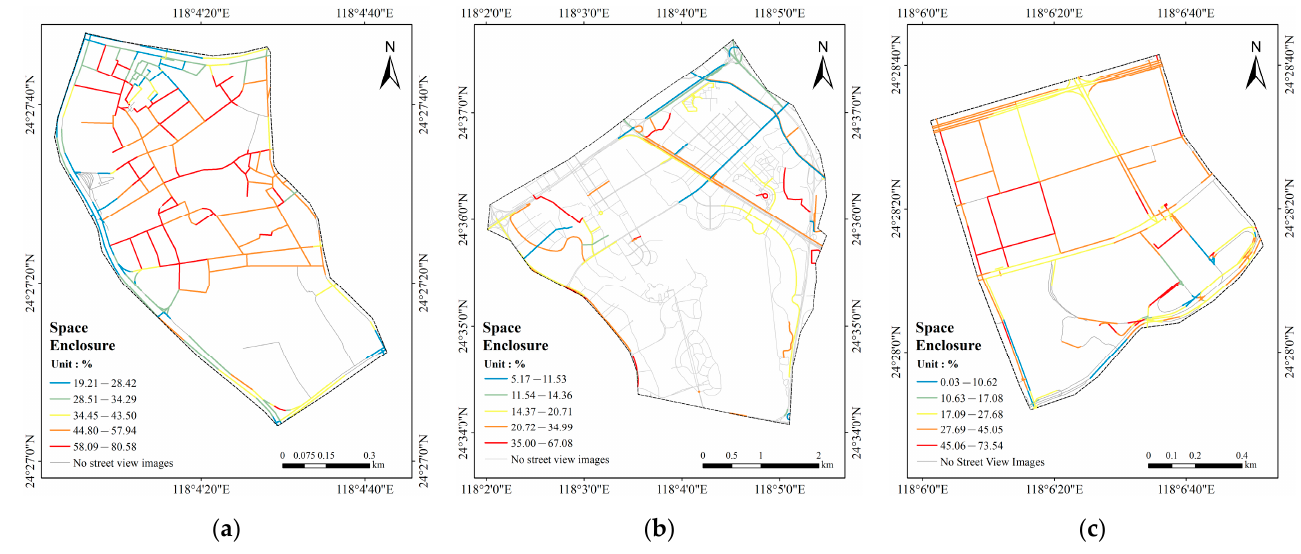
ISPRS Int. J. Geo-Inf. 2022 , 11 , x FOR PEER REVIEW Figure 7. Visualisation results of space enclosure in ( a ) Area Ⅰ , ( b ) Area Ⅱ , and ( c ) Area Ⅲ . Figure 7. Visualisation results of space enclosure in ( a ) Area I, ( b ) Area II, and ( c ) Area III.